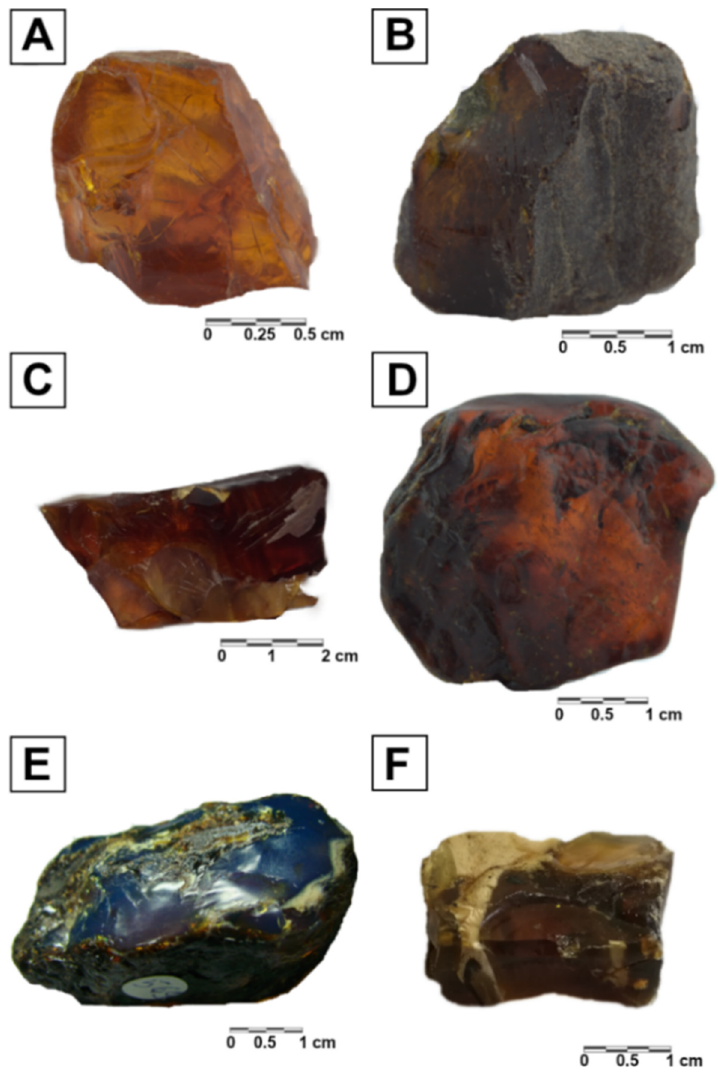
Figure 1. Figure 1. Cont.